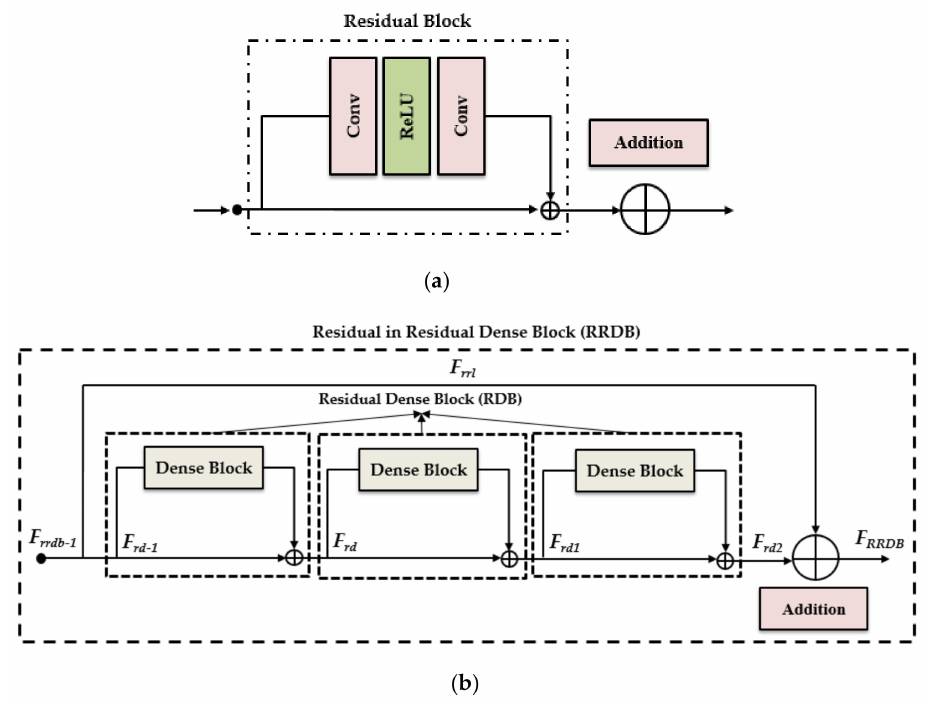
Figure 1. Comparison of residual blocks in the enhanced deep residual network (EDSR) and our proposed model. ( a ) EDSR residual block, ( b ) Proposed model with residual block (residual in residual dense block